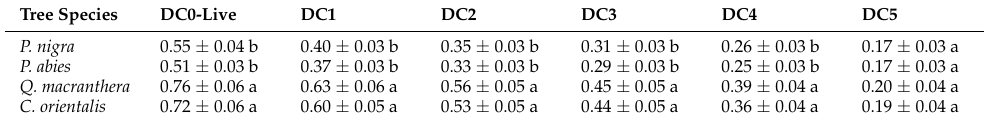
Table 3. Wood basic density (mean ± SD, g cm − 3 ) of trees species and decay classes. Tree